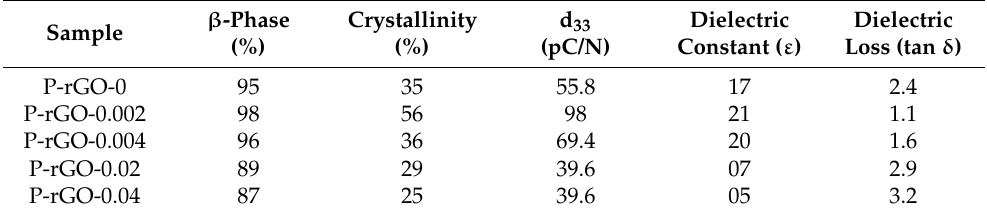
Table 4. Summarized characteristics of five thin